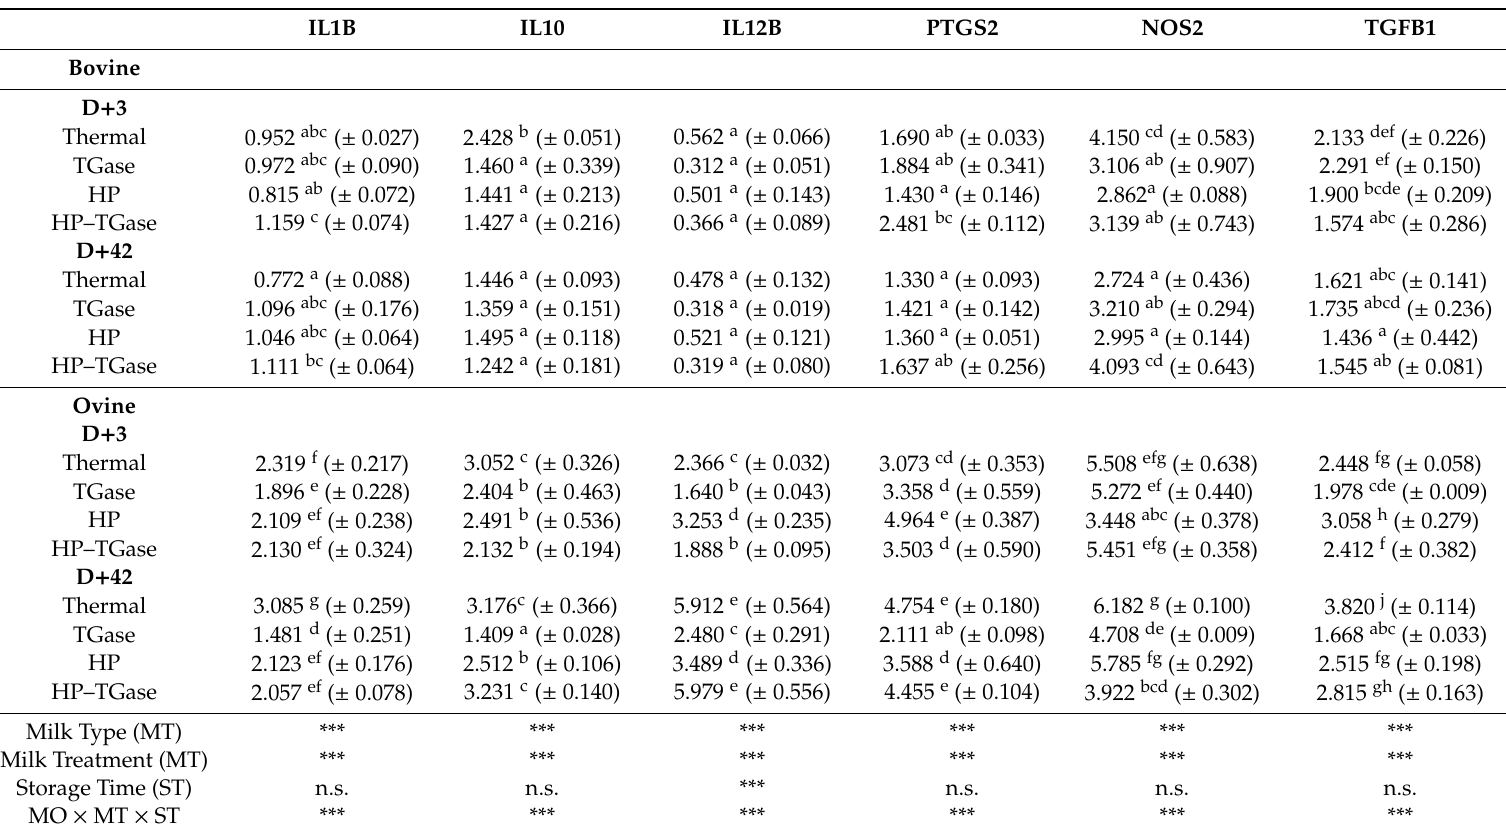
Table 4. Immunomodulatory properties of bovine and ovine yoghurt WSEs as evaluated though the expression of pro-inflammatory and anti-inflammatory genes by ovine monocytes, and analyzed after 3 (D + 3) and 42 (D + 42) days of yoghurt sample